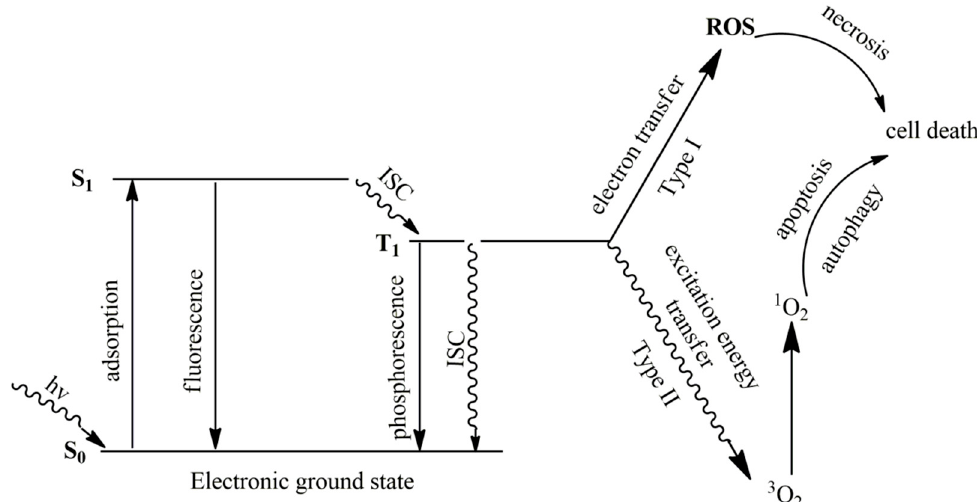
Figure 1. Modified Jabłonski’s diagram illustrating the principle of photodynamic therapy (ROS = reactive oxygen species). (cf to text for explanation). Adapted from [45] with permission from Acc. Chem. Res. , Copyright ACS 2017.